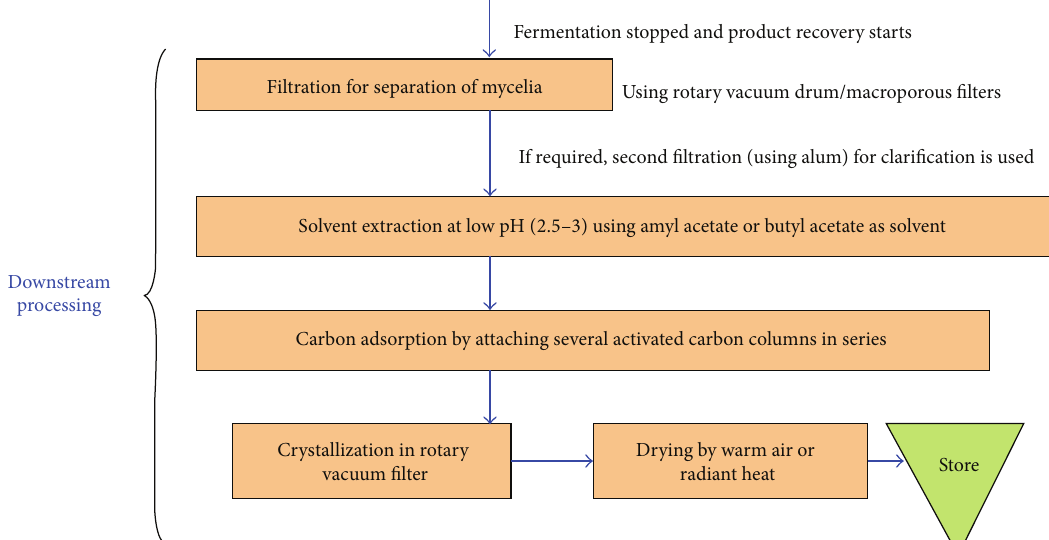
Figure 1: Schematic representation for large-scale production of Penicillin G (reproduced and redrawn from elsewhere [30]). Steps are self- explanatory. For a detailed account, see the source [30]. “OUR”: oxygen uptake rate, “OTR”: oxygen transfer rate, “MCB”: master cell bank, and “MWCB”: manufacturer’s working cell